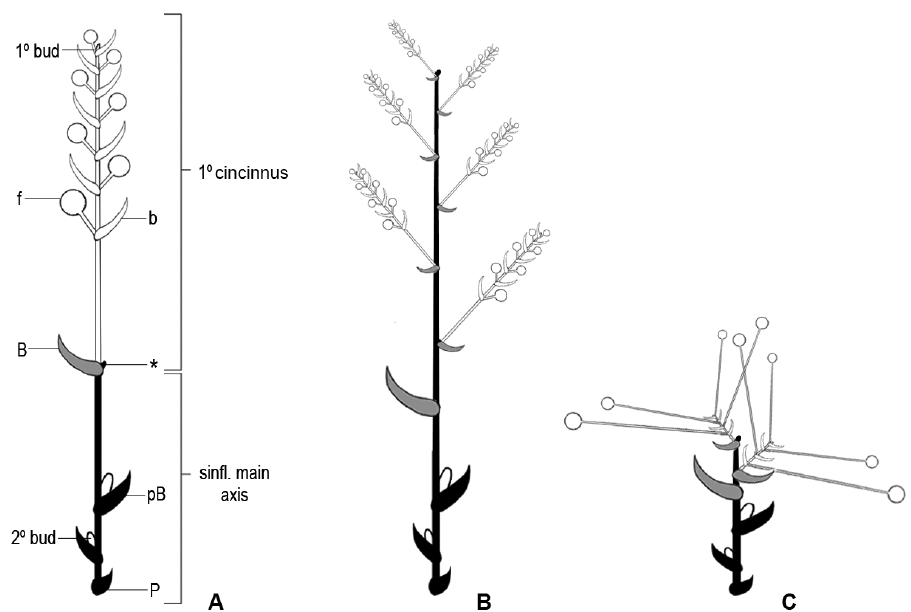
Figure 4. Inflorescence architecture in Dichorisandrinae s.s . A diagram of the basic Siderasis Raf. emend M.Pell. & Faden inflorescence type, consisting of a thyrse reduced to a solitary cincinnus B diagram of the basic Dichorisandra inflorescence type (also characteristic of S. spectabilis and S. zorzanellii ), consisting of a many-branched thyrse with alternate, many-flowered cincinni C diagram of the basic D. acaulis spe- cies group inflorescence type, where the main florescence axis and cincinni axis are greatly reduced, and the pedicels are peculiarly elongated. P = prophyll; pB = peduncle bract on main synflorescence axis; * = aborted or dormant apex of main inflorescence axis (usually not observed); B = cincinnus bract; b = brac- teole; f = flower; 1°bud = bud terminating cincinnus; 2°bud = bud in axil of peduncle bract with potential to develop into a secondary thyrse (coflorescence); Modified from Pellegrini